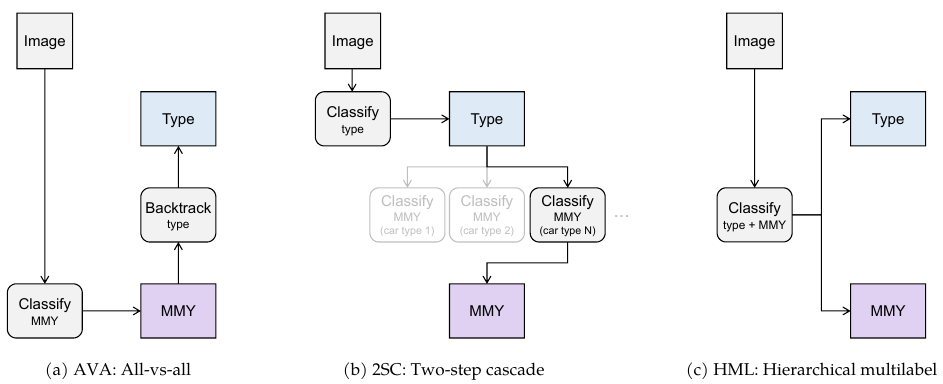
Figure 5. Three classification approaches devised for our revisited version of the CompCars